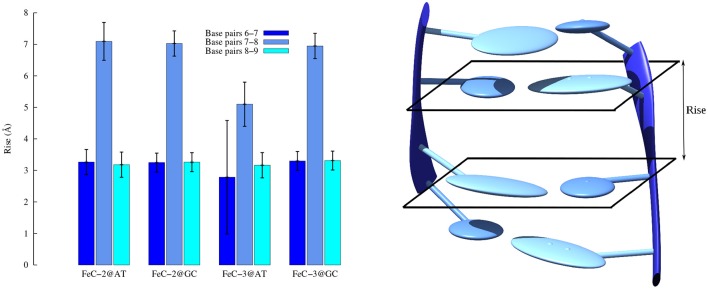
Average rise parameter for DNA interacting with FeC-2 and FeC-3. The complex is intercalated in between base pairs 7–8. On the right a cartoon representation of the rise parameter.